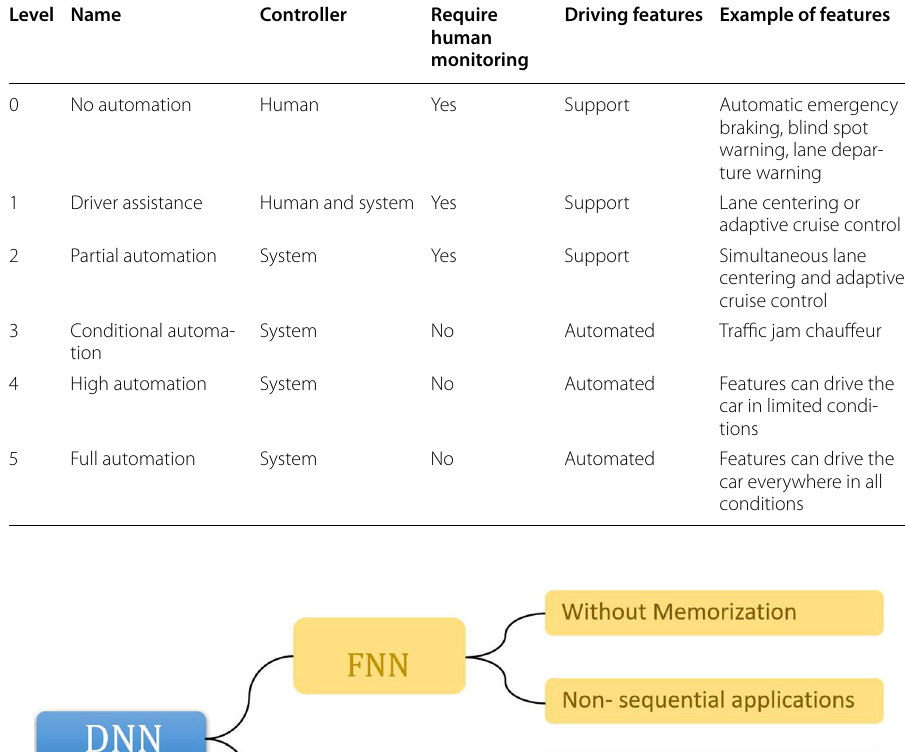
Table 1 The six levels of vehicle automation systems